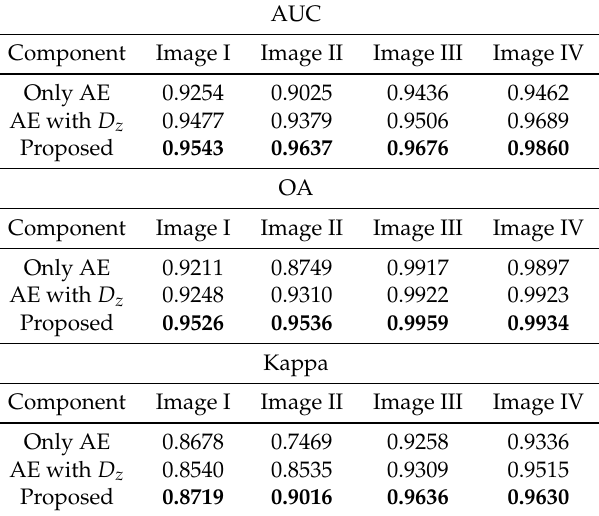
Table 3. The area under the curve (AUC), overall accuracy (OA) and Kappa for component analysis of UNCD for different datasets. AE: autoencoder. The bold fonts indicate the best results.